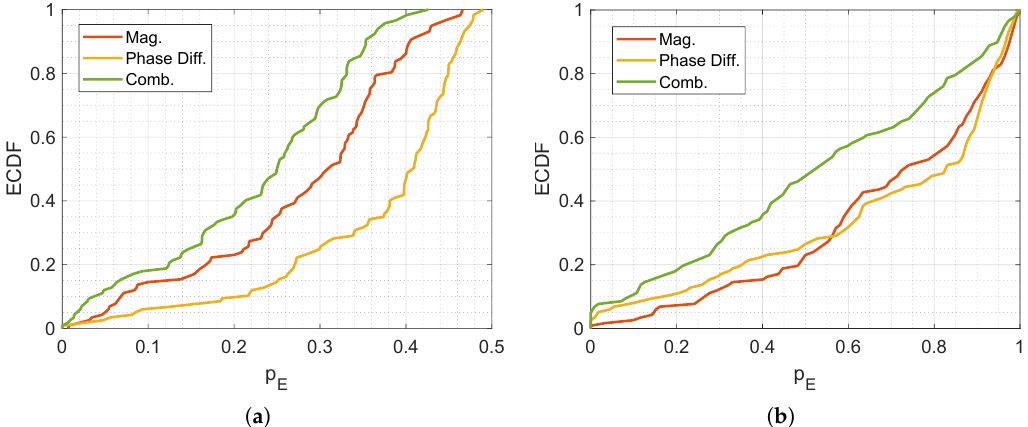
Figure 16. ECDFs for the simulated and measured error probability. ( a ) p E determined by simulation. ( b ) Relative incidence of localization error determined by fingerprinting.